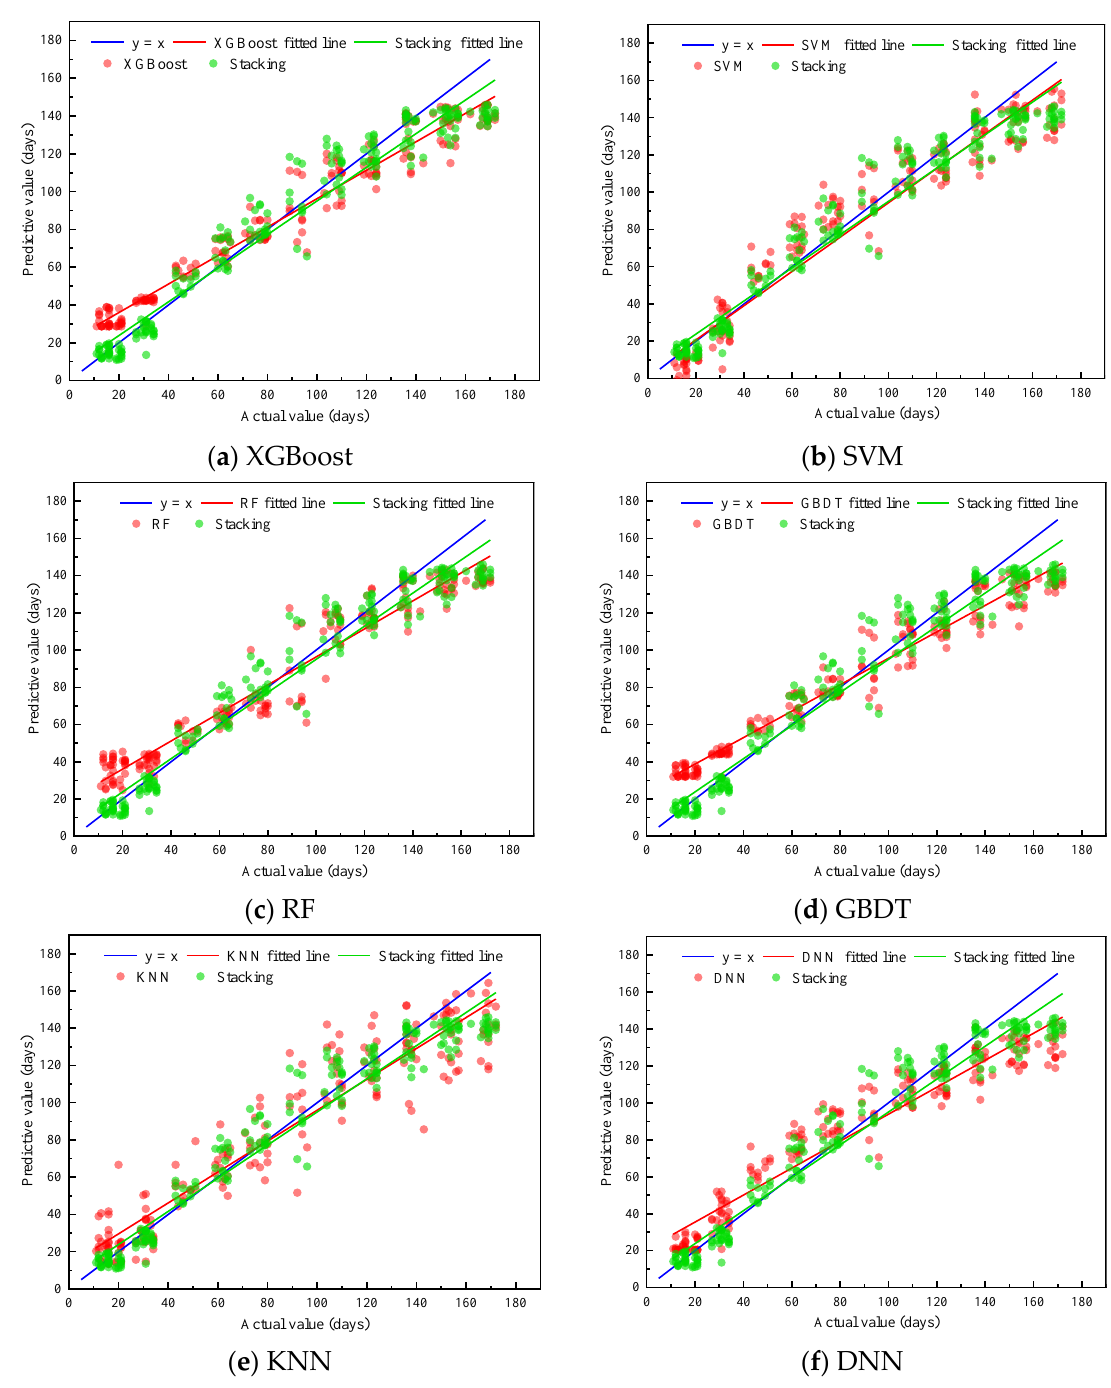
Figure 13. Comparison of the prediction errors produced by the XGBoost, SVM, RF, GBDT, KNN, DNN and stacking models.